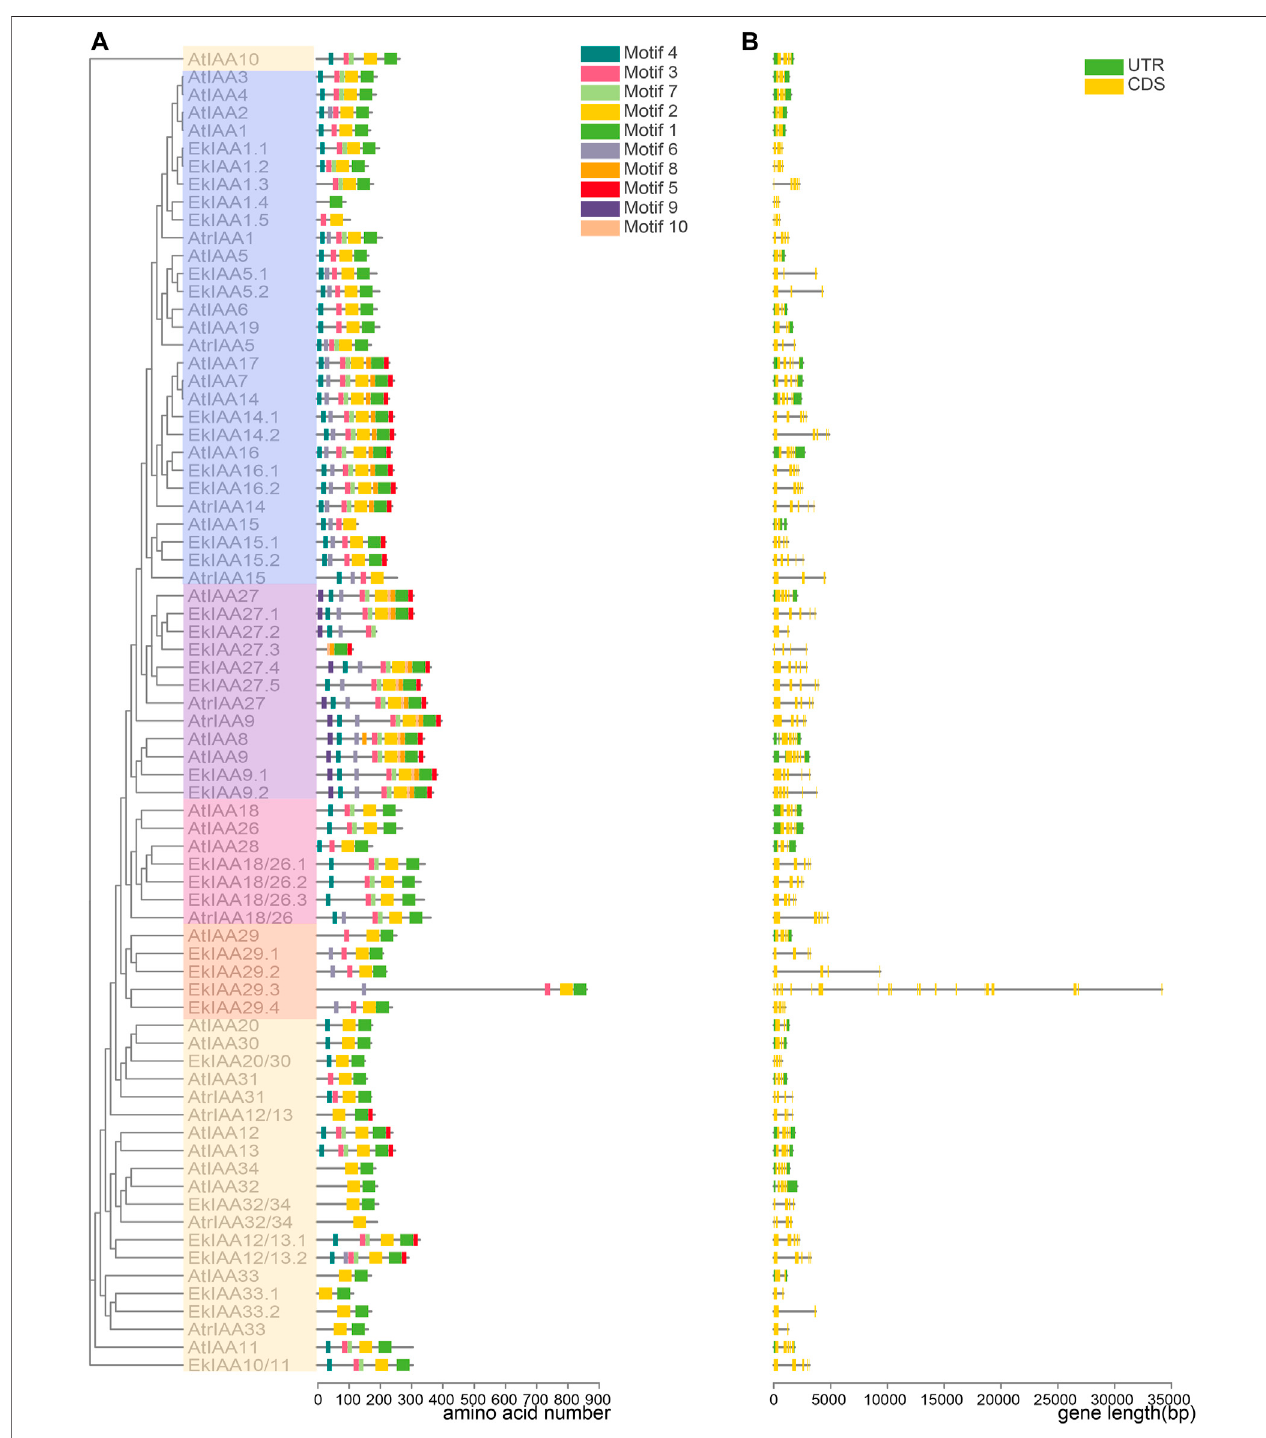
FIGURE 4 | Gene structures of EkIAA s and conserved motifs in EkIAAs. (A) EkIAA phylogenetic tree and corresponding EkIAA gene structures. (B) Conserved proteinmotifswithinEkIAAs.Thephylogenetictreewasgenerated usingtheIQ-tree webserver.Genestructures of EkIAA swerepredicted withTBtools. Theconserved motifs were analyzed using the MEME web